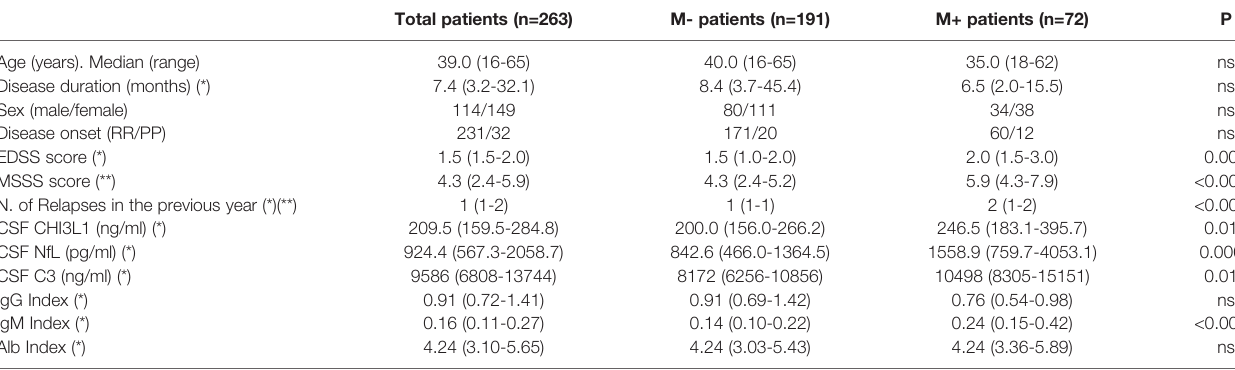
TABLE 1 | Clinical and demographic data of patients included in the study.